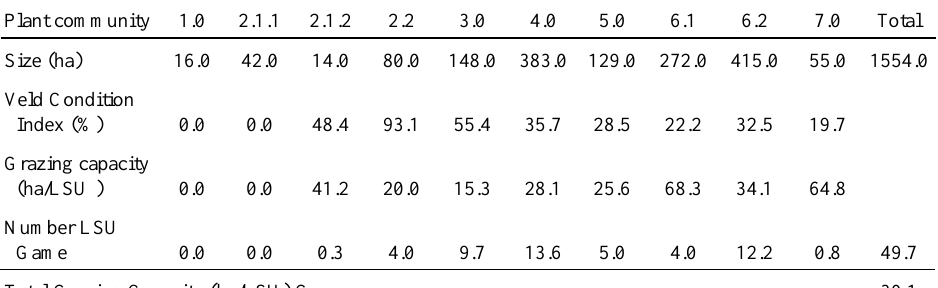
Veld condition and grazing capacity for Ingleside and Welgedacht farms, Mountain Zebra National Park Plant